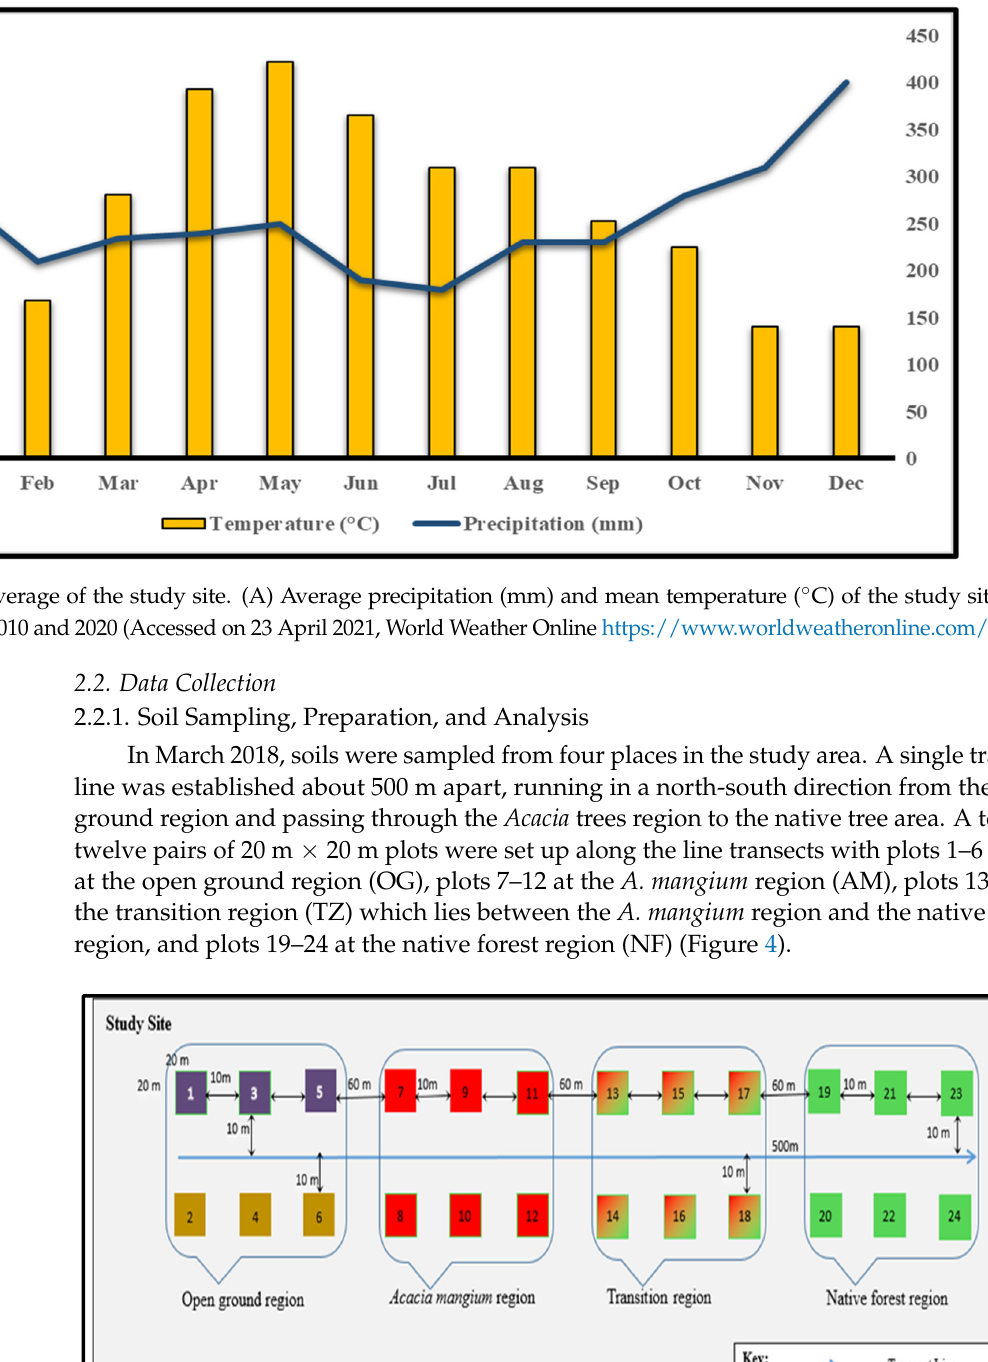
Table 1. Description of plot placement.